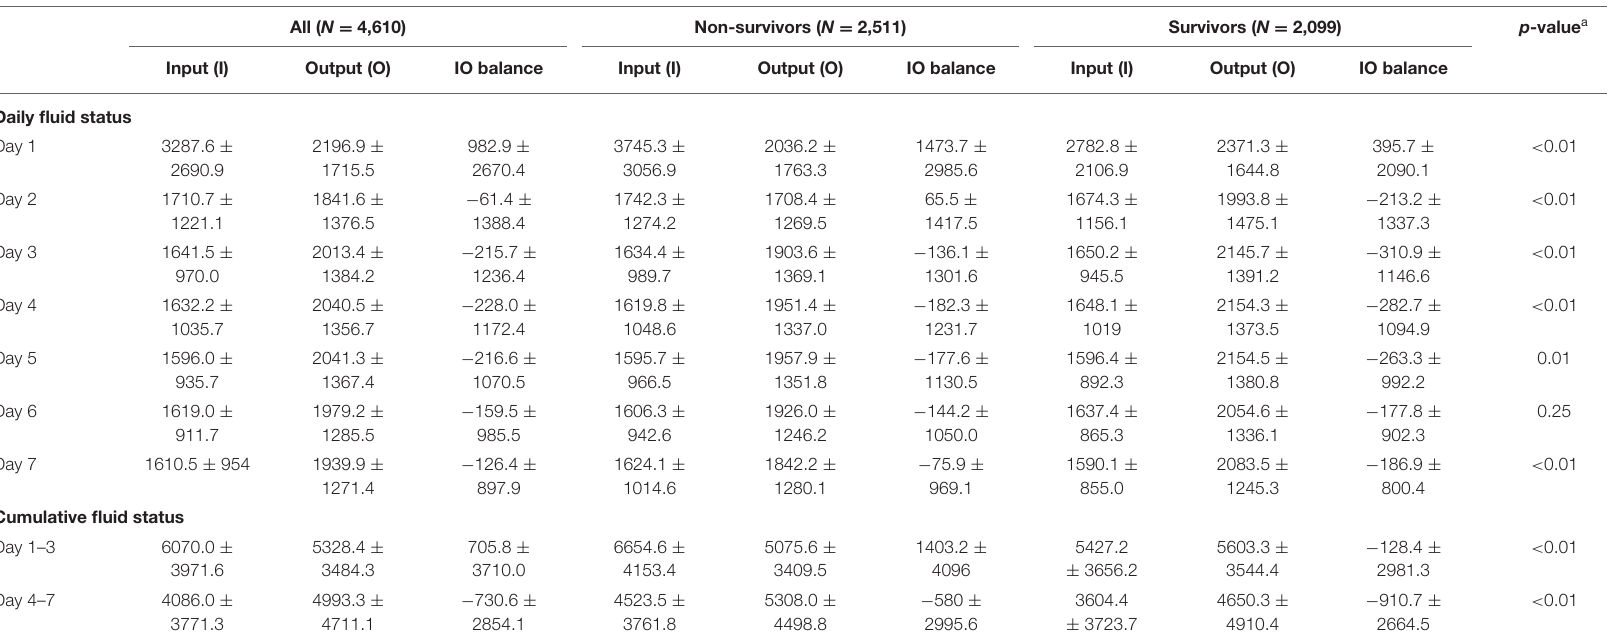
TABLE 2 | Daily and cumulative fluid status in critically ill patients categorized by long-term mortality.